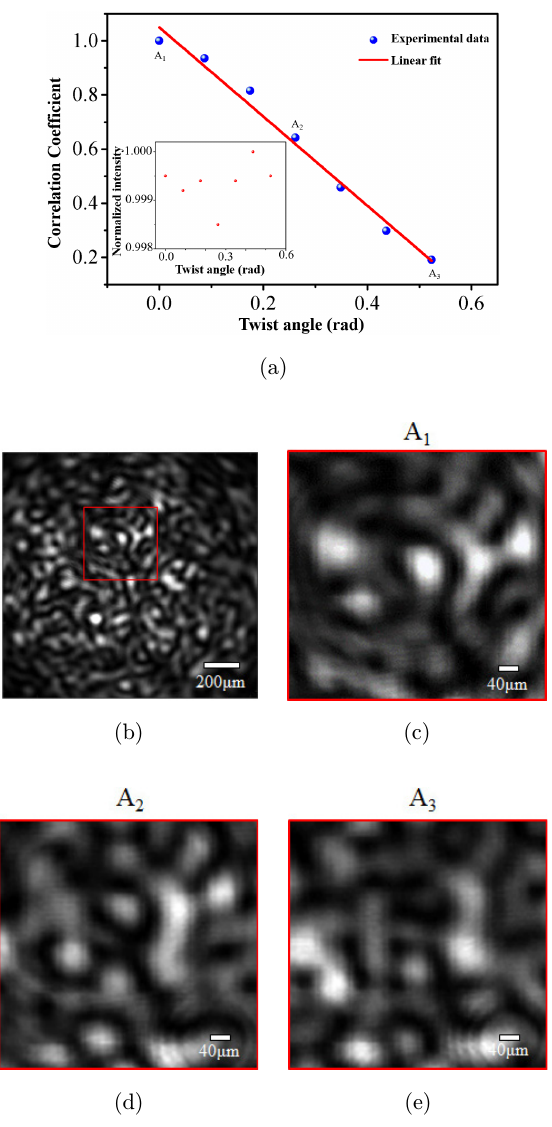
Fig. 3. (a) Measured speckle CC versus ¯ber twist angle. The relationship between the corresponding light intensity and the twist angle is shown in the inset. (b) The region selected can be zoomed in (indicated in red box) for better view of the details of the speckle patterns (the ROI is not changed). (c) – (e) Three sampled speckle patterns corresponding to A 1 (cid:1) 3 twist angles in